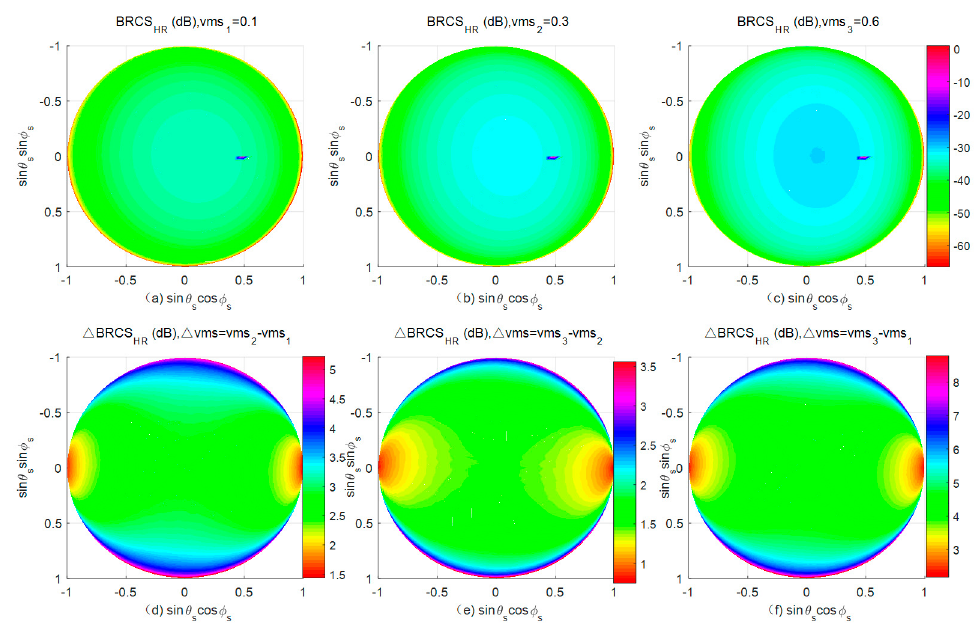
Figure 10. BRCS for different soil moisture contents ( a – c ) and the BRCS differences for different soil moisture differences ( d – f ) at HR polarization.